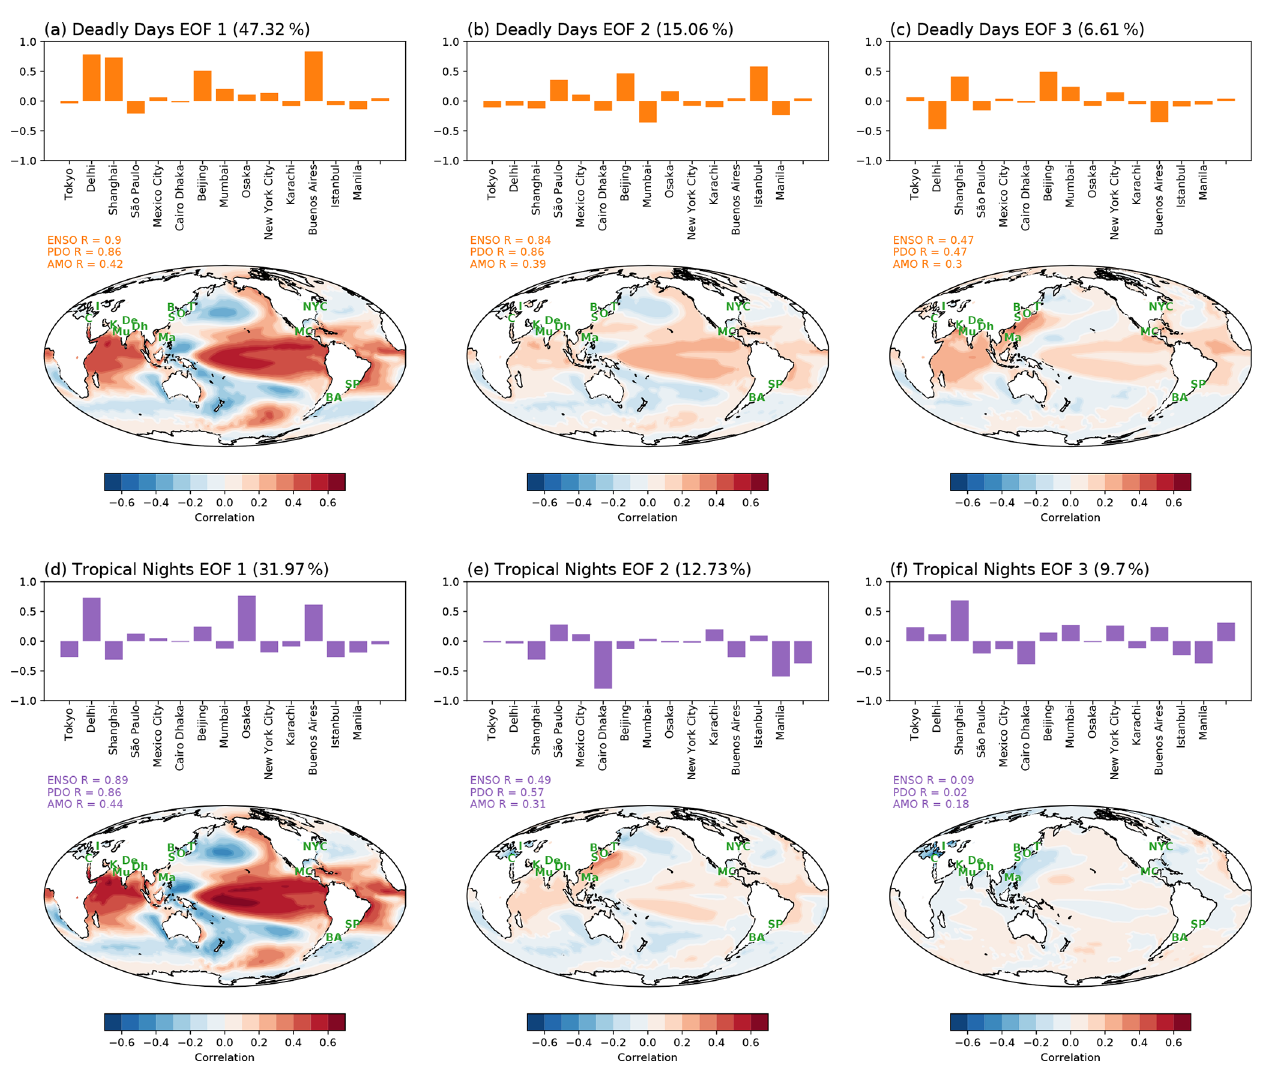
Figure 3. The first three EOFs of annual values of deadly days (a–c) and tropical nights (d–f) in the world’s 15 largest cities. For each panel, the bar graph shows the EOF pattern of the number of heat extreme days per year. Contour plots shows the SST pattern associated with the EOF mode, obtained by projecting each mode of PC onto SST anomalies. Ensemble members are averaged to yield the SST pattern. Pattern correlations with major modes of climate variability (ENSO, PDO, and AMO) are also shown, as discussed in the